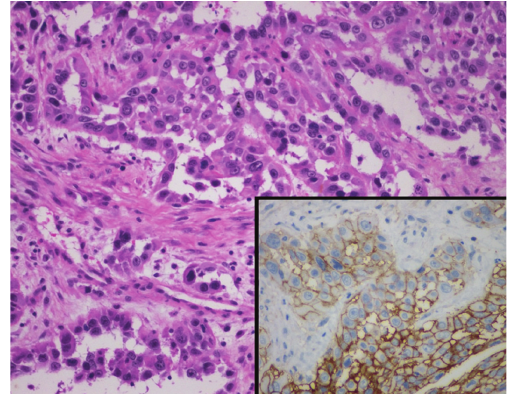
Figure 2: Atypical proliferate epithelial cells arranged like irregular glands (as in adenocarcinoma) and distributed among a fibrous substance. Atypical proliferate epithelial cells are immunoreactive for CD99 (insert). (Hematoxylin-eosin stain; original magnification × 200) (insert × 400).